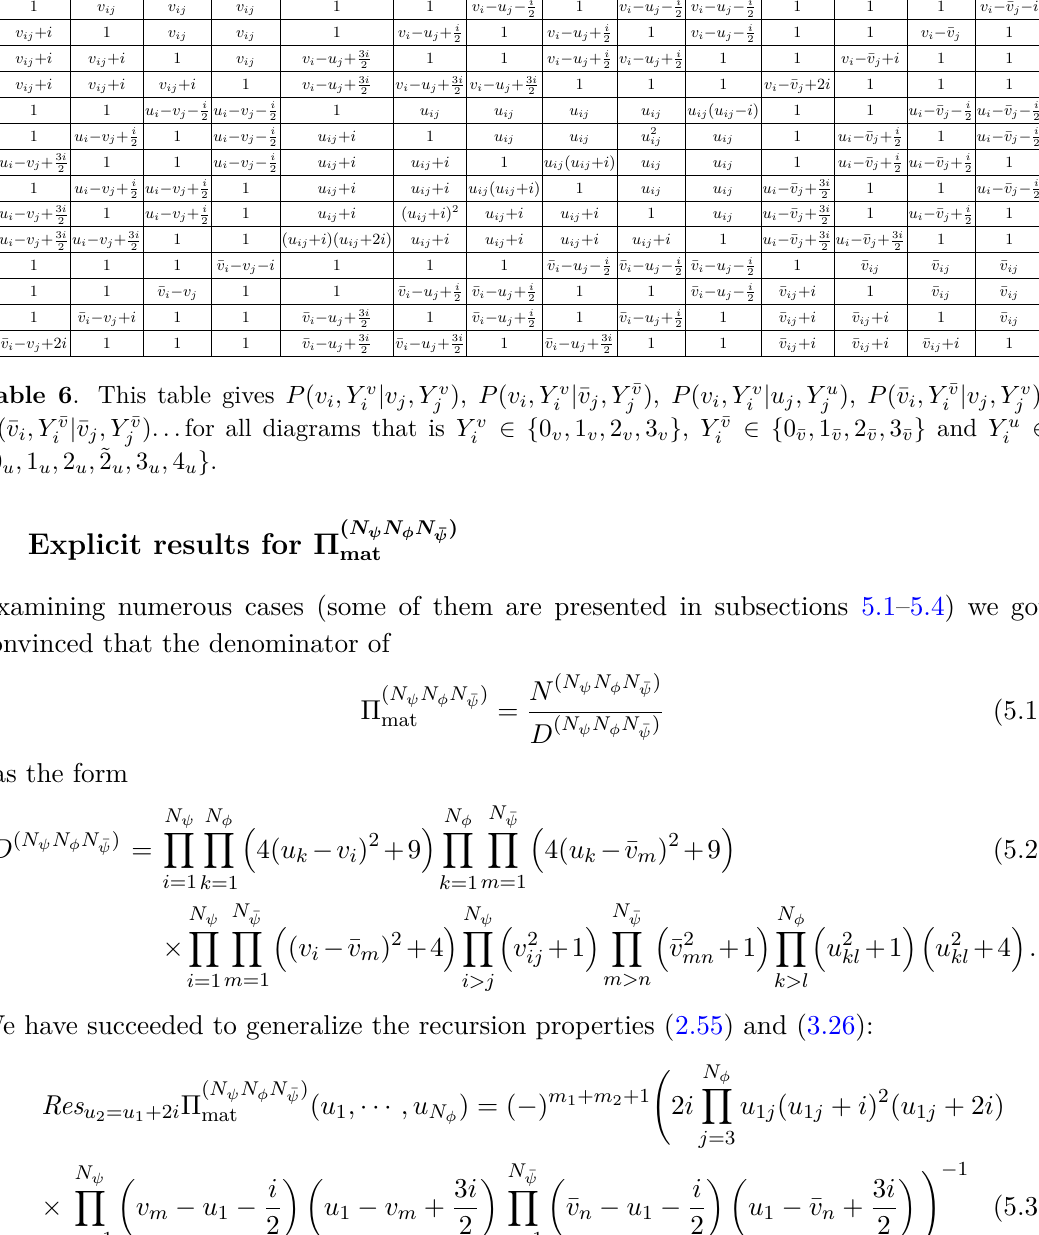
Table 6 . This table gives P ( v i , Y v